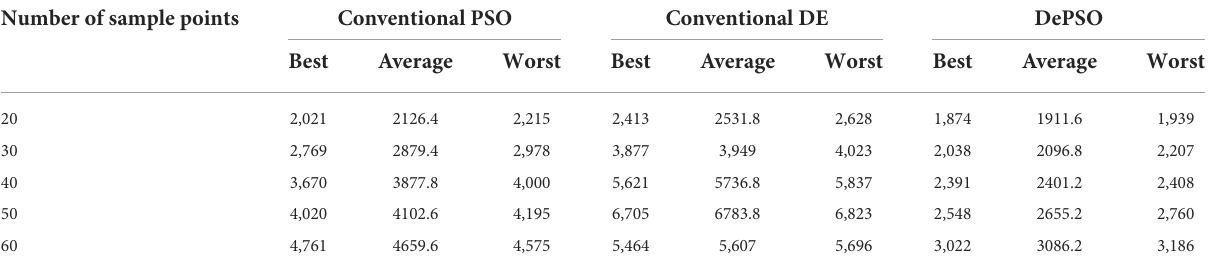
TABLE 5 Comparison of path lengths with PSO, DE, and DePSO. Number of sample points